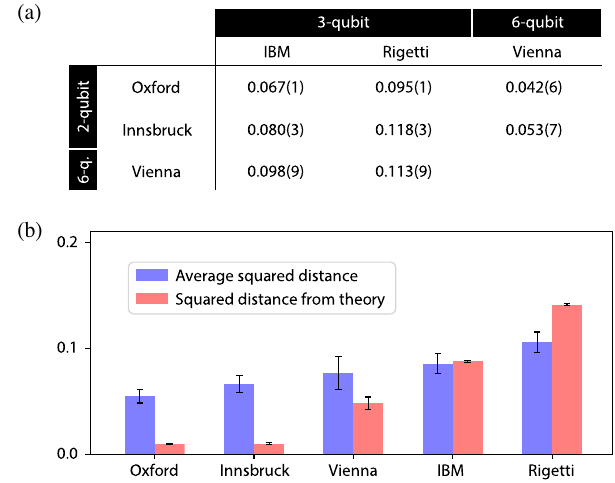
FIG. 3. Experimental comparison of quantum devices. (a) Ex- perimental squared l 2 distances between pairs of independent quantum devices, averaged over 34 instances. Only computations using different numbers of physical qubits are compared, so the implementations represent fundamentally different sampling problems. Uncertainties in parentheses correspond to 1 standard deviation of statistical noise. (b) Squared l 2 distances for each quantum device averaged over comparisons to all other devices (blue). To illustrate that this metric qualitatively captures the performance of the individual devices, we also show the squared l 2 distances of each device against the (nonscalable) theory prediction (red). These two quantities are not expected to coincide. However, arranging devices according to either metric yields the same order in our